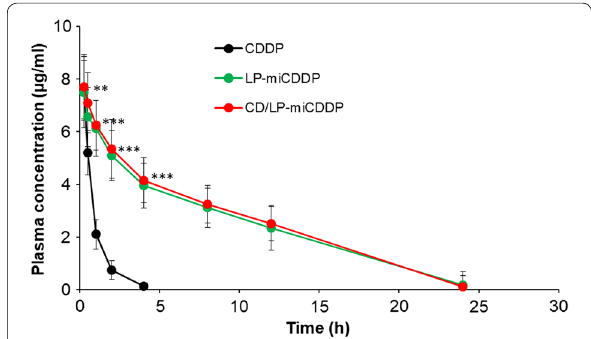
Fig. 8 Plasma concentration–time profile of free CDDP, LP‑miCDDP and CD/LP‑miCDDP. The free drug and formulations were administered in SD rats by tail‑vein injection and studied until 24 h. ***p < 0.0001, CD/LP‑miCDDP and vs free